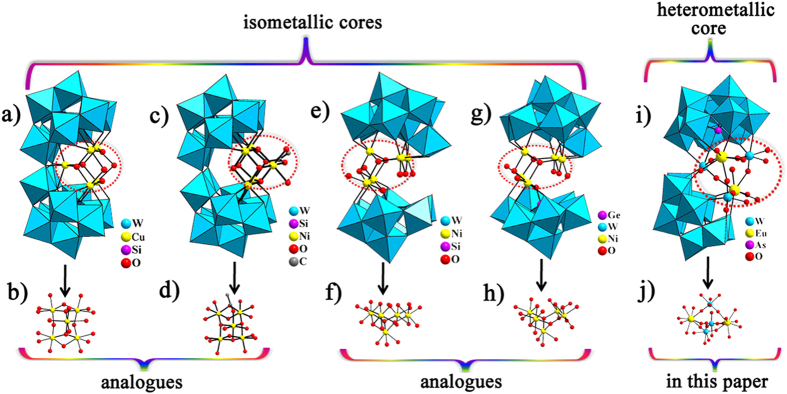
(a) View of
[Cu5(OH)4(H2O)2(A-α-SiW9O33)2]10−.
(b) View of the monometallic pentanuclear
[Cu5(OH)4(H2O)2]6+
core. (c) View of
{[Ni5(OH)3(H2O)4(CH3CO2)][Si2W18O66]}6−.
(d) View of the monometallic pentanuclear
[Ni5(OH)3(H2O)4
(CH3CO2)]6+ core. (e) View
of
[H2{Ni5(H2O)5(OH)3(x-SiW9
O34)
(β-SiW8O31)}2]24−.
(f) View of the monometallic pentanuclear
[Ni5(H2O)5(OH)3]+7
core. (g) View of
[Ni5(OH)4(H2O)4(β-GeW9O34)(β-GeW8O30(OH))]13−.
(h) View of the monometallic pentanuclear
[Ni5(OH)4(H2O)4]6+
core. (i) The skeleton of 1c. (j) View of the
heterometallic pentanuclear
[Eu2(H2O)6W3O10]4+
core.